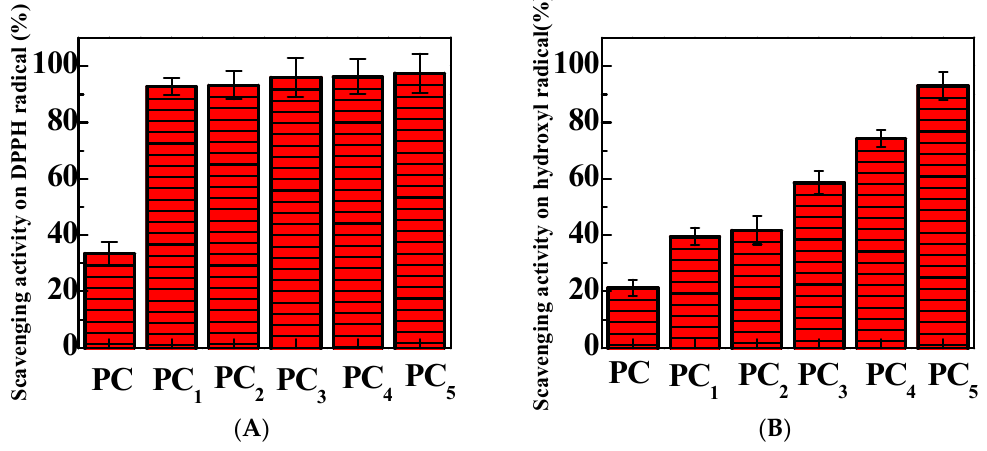
Figure 8. Average scavenging effects of PC composite films on ( A ) DPPH and ( B ) hydroxyl free radicals.